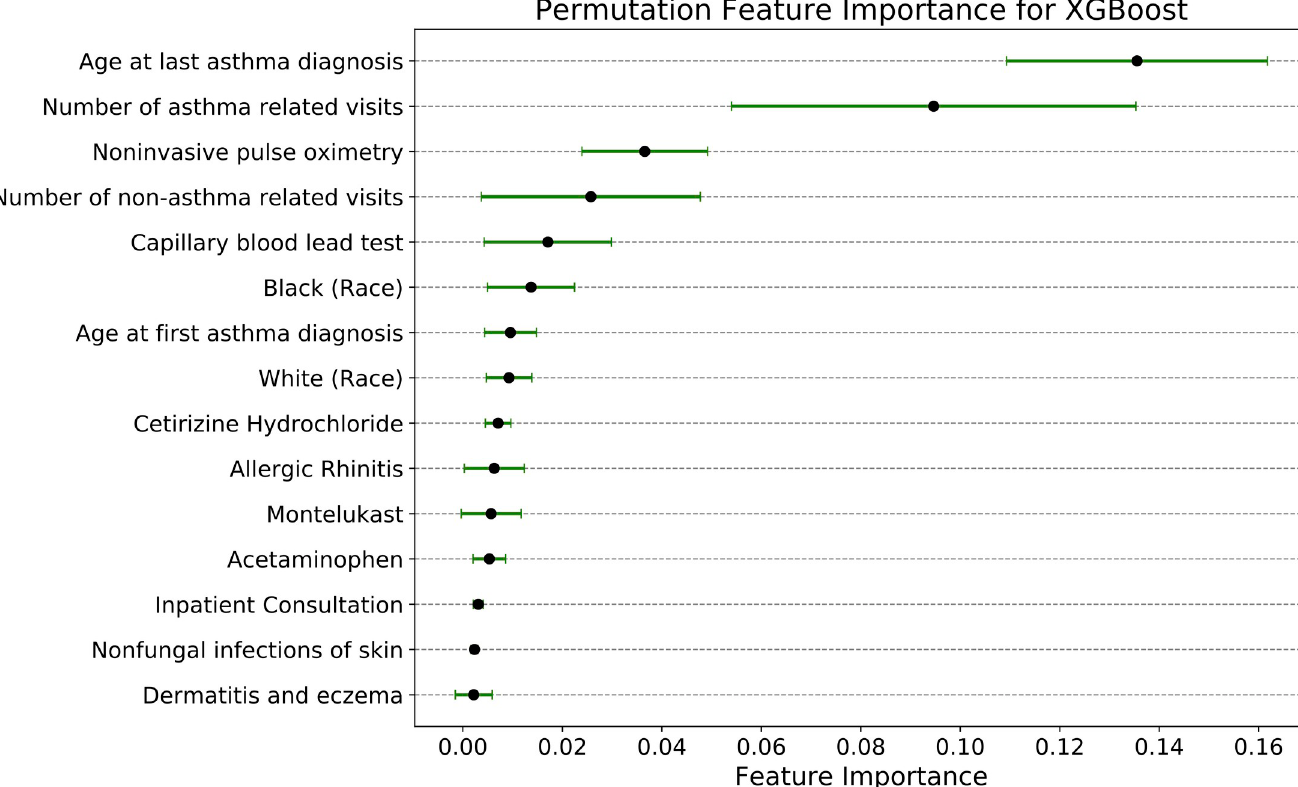
PLOS ONE | https://doi.org/10.1371/journal.pone.0247784 March 1,